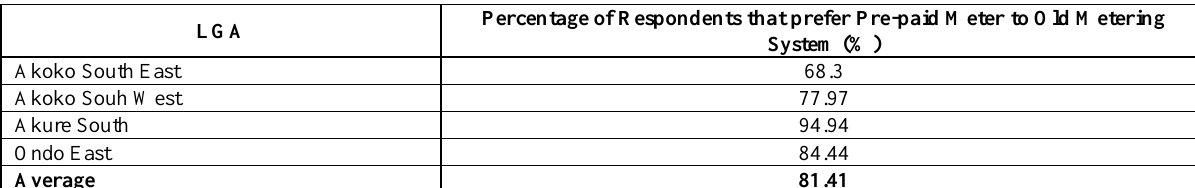
Table 6. Household Preference for Pre-Paid